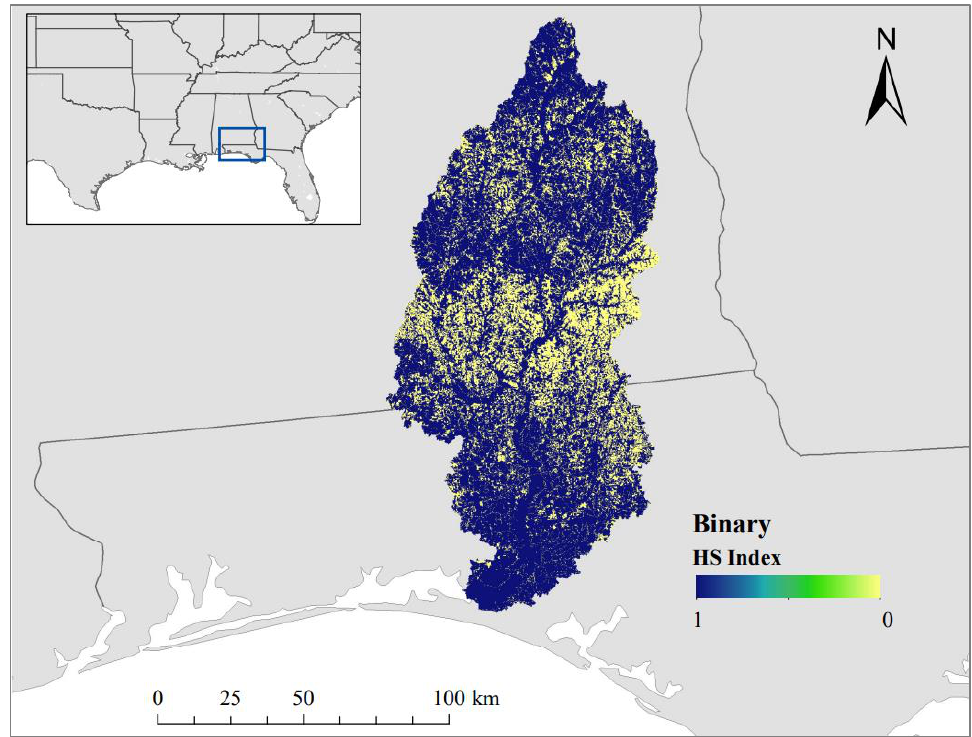
Figure 2. The habitat suitability map of the Choctawhatchee Watershed using the binary method (Method 1). (Method